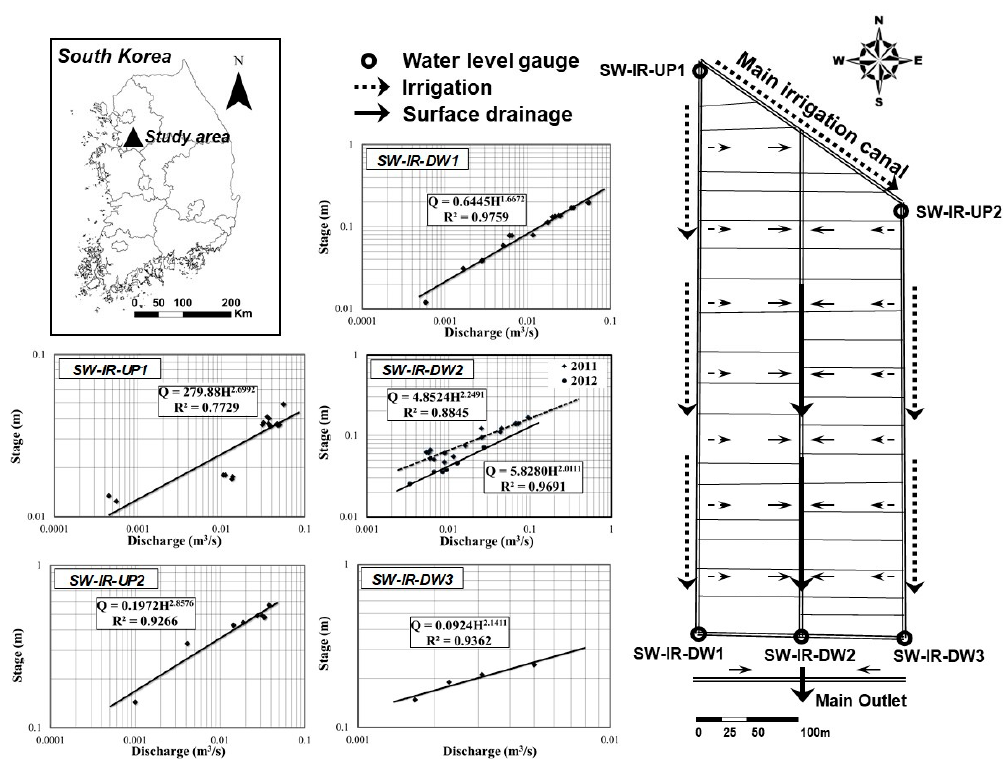
Figure 3. Schematics of the irrigation and drainage monitoring system for the study paddy block.